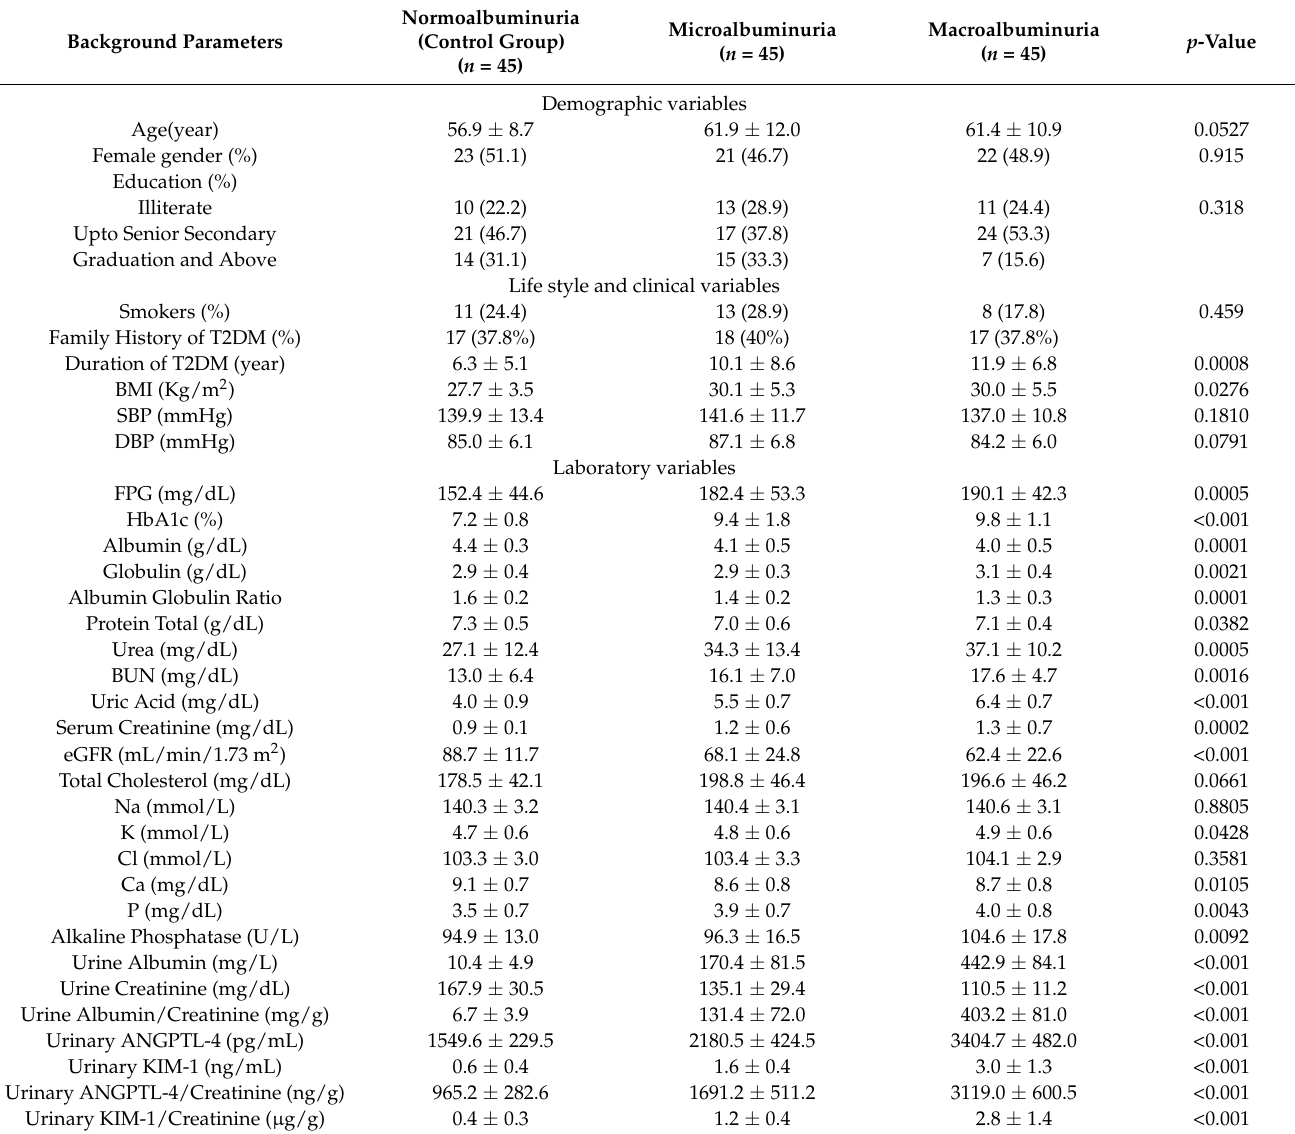
Table 1. Comparison of demographic, clinical, and laboratory parameters between the patient